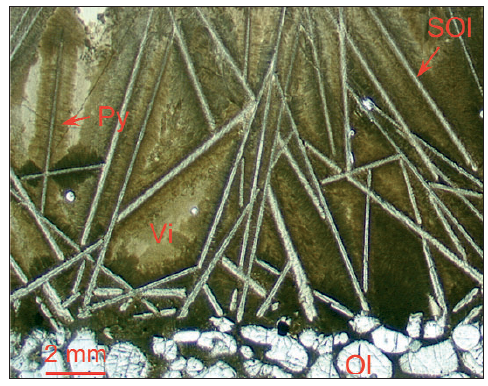
Fig. 3. Optical micrograph of remelting product from black sand. Melting condition: 1400°C, 0.45 h in air; Ol – residual olivine phenocrysts; SOL– skele- tal